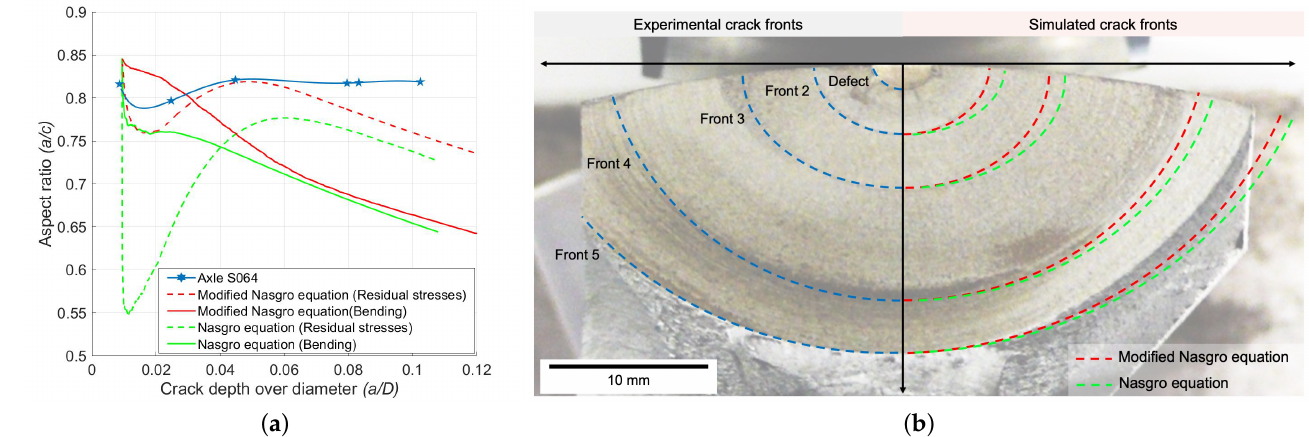
Figure 10. Crack shape evolution analysis of Axle S067: ( a ) Crack shape aspect ratio a / c comparison between numerical prediction and experimental and ( b ) contour plot of the crack shape evaluated by considering residual stresses the comparison with the experimental